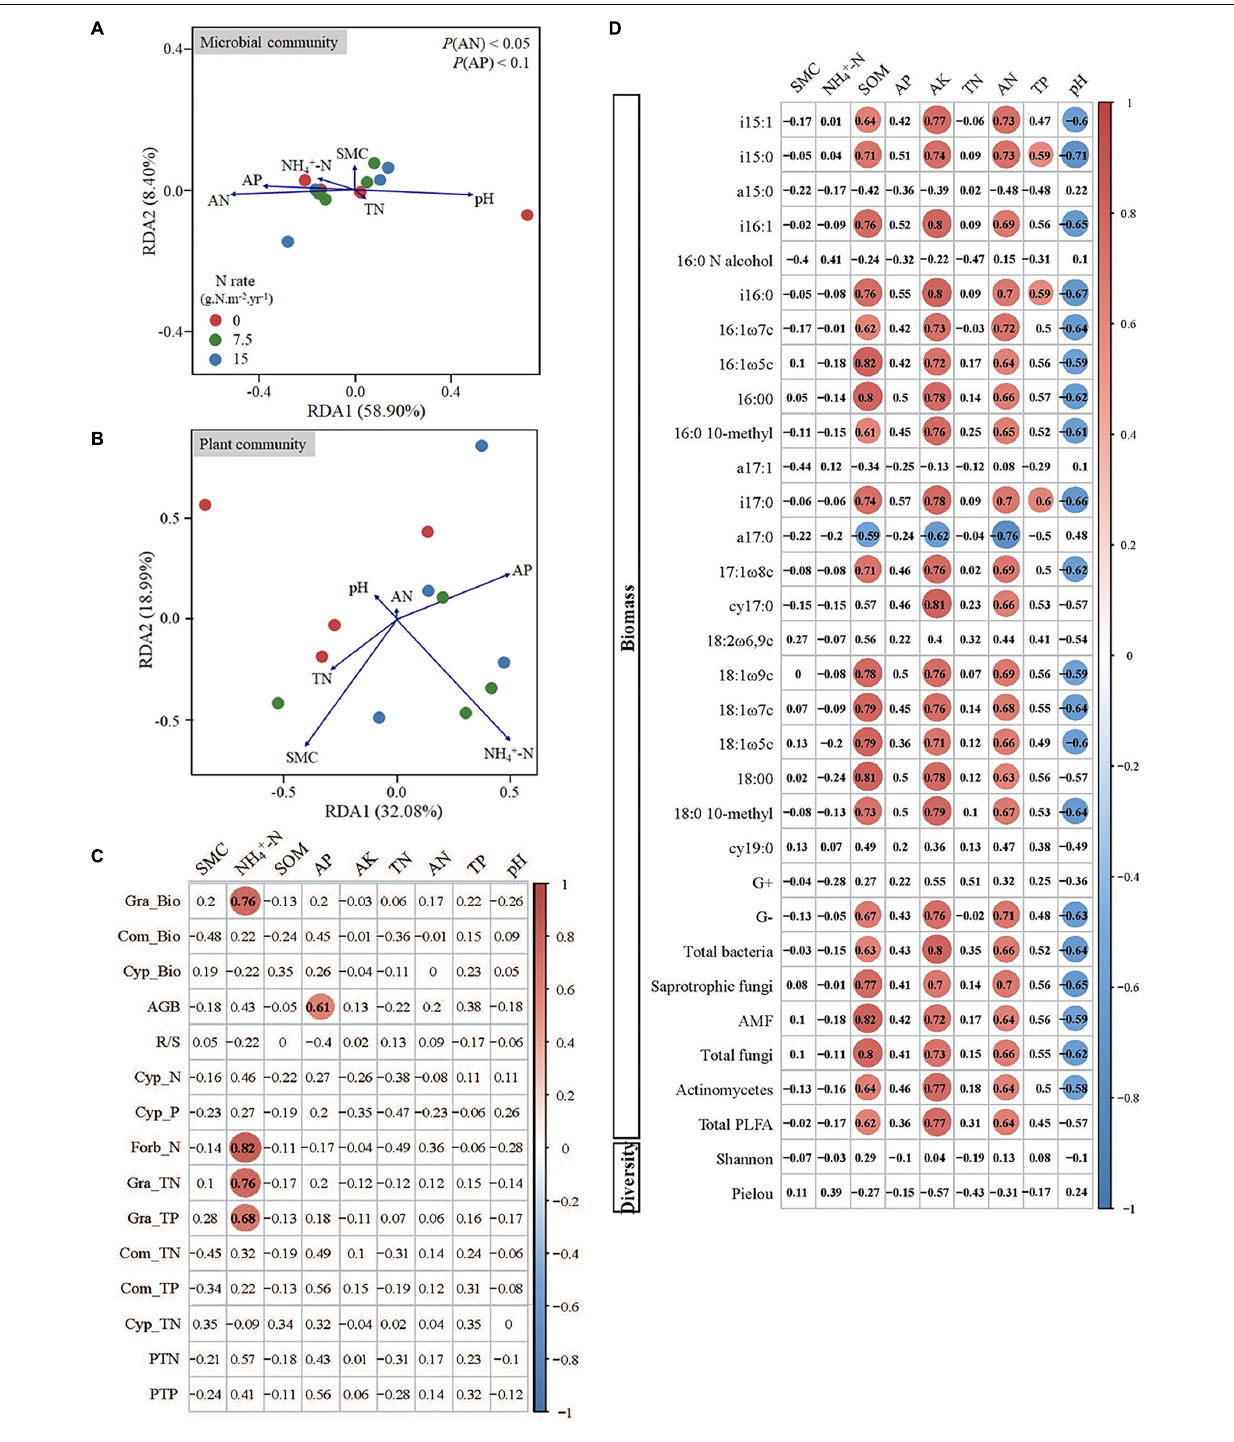
Frontiers in Plant Science |